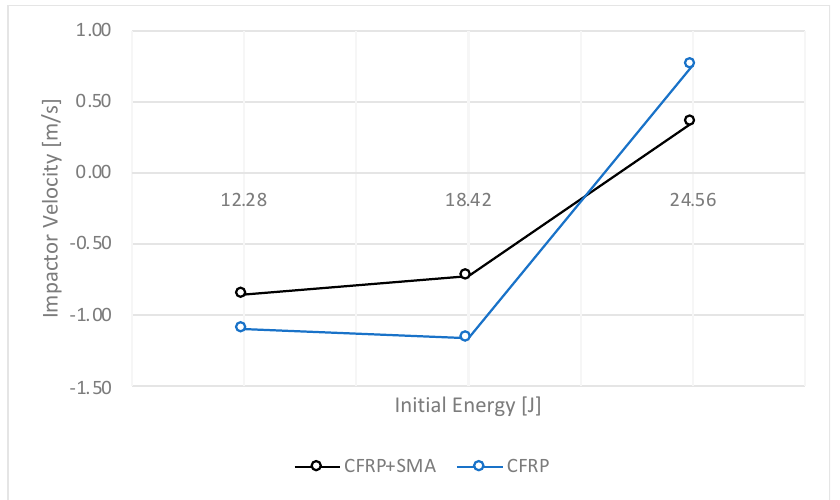
Figure 6. Impactor rebound velocity.